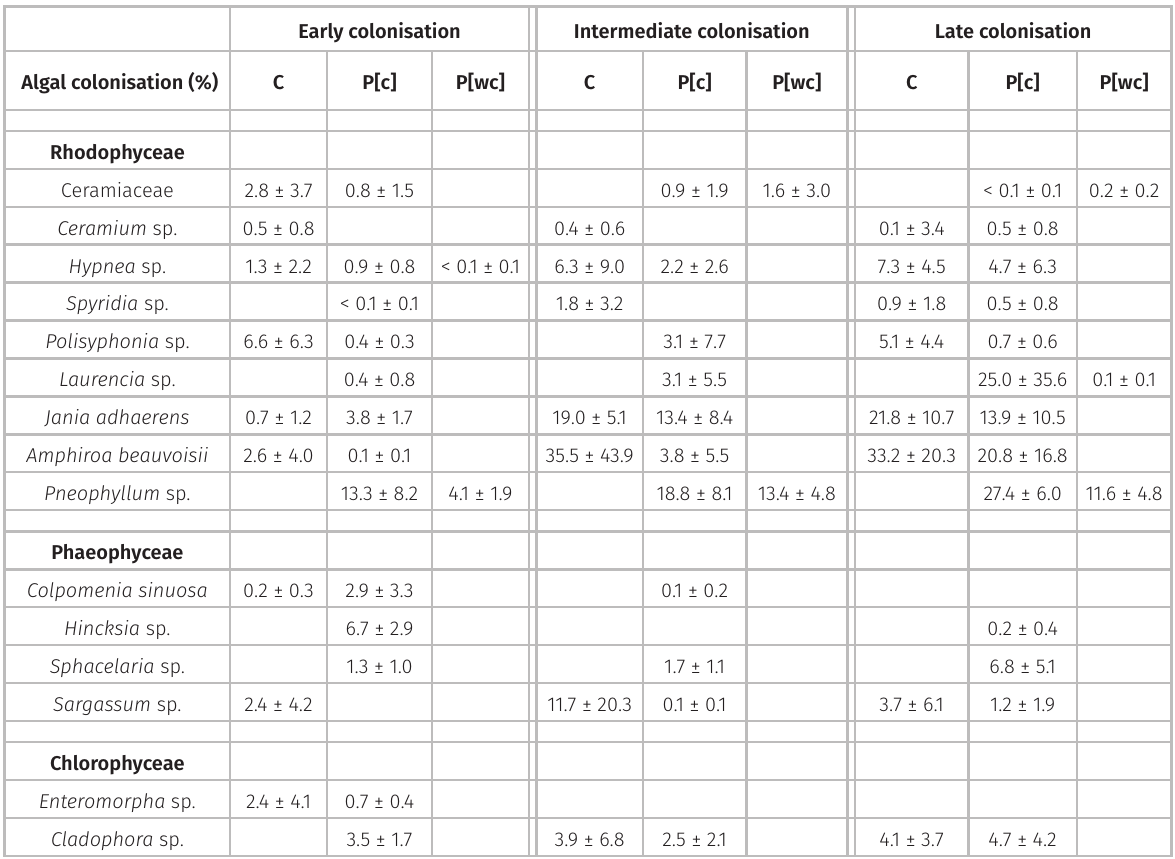
Table I. Percentage (± SD) of colonised algal coverage on scraped coral (C) and recruitment plates in the region with corals (P [c]) and without corals